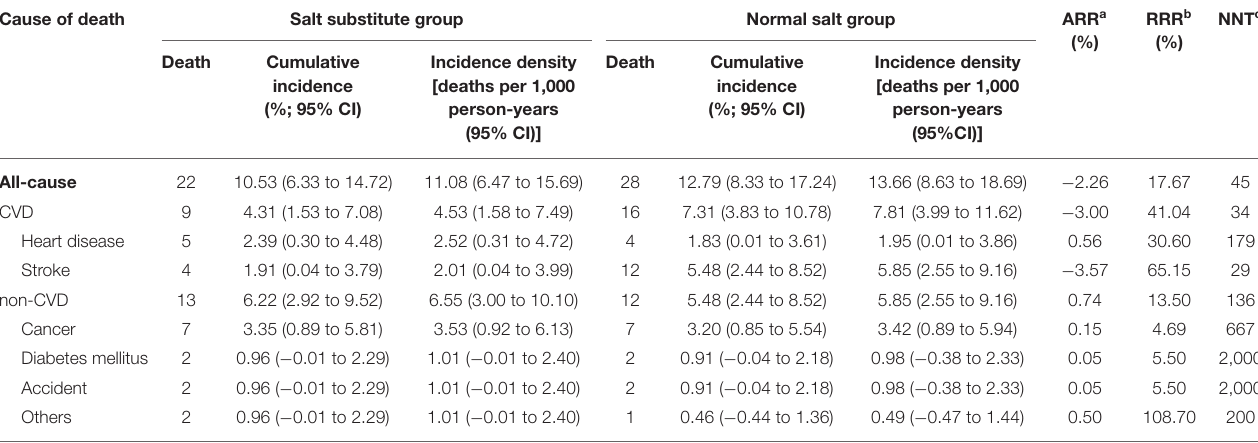
TABLE 2 | Cause-specific mortality in groups and efficacy of salt substitute on mortality. Cause of death Salt substitute group Normal salt group ARR a RRR b NNT c (%) (%) Incidence density Incidence density Death Cumulative Death Cumulative [deaths per 1,000 [deaths per 1,000 incidence incidence person-years person-years (%; 95% CI) (%; 95% CI) (95% CI)]